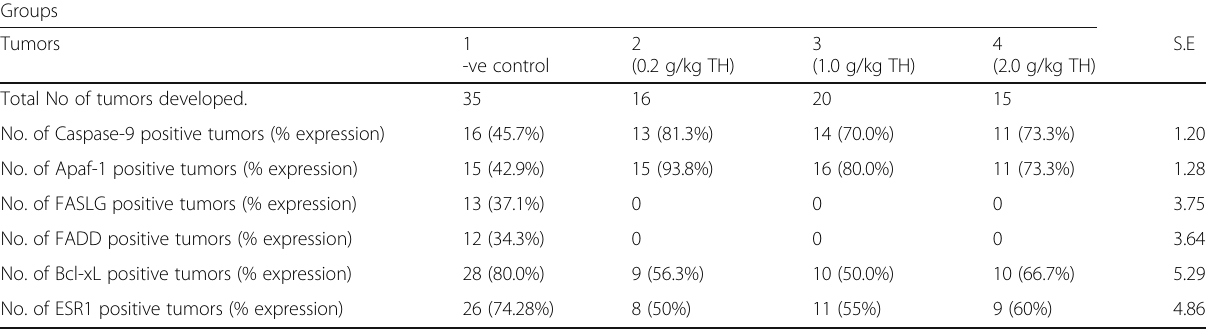
Table 5 Immunohistochemical expression of pro- and anti-apoptotic proteins in breast tumors treated and non-treated with Tualang honey Groups